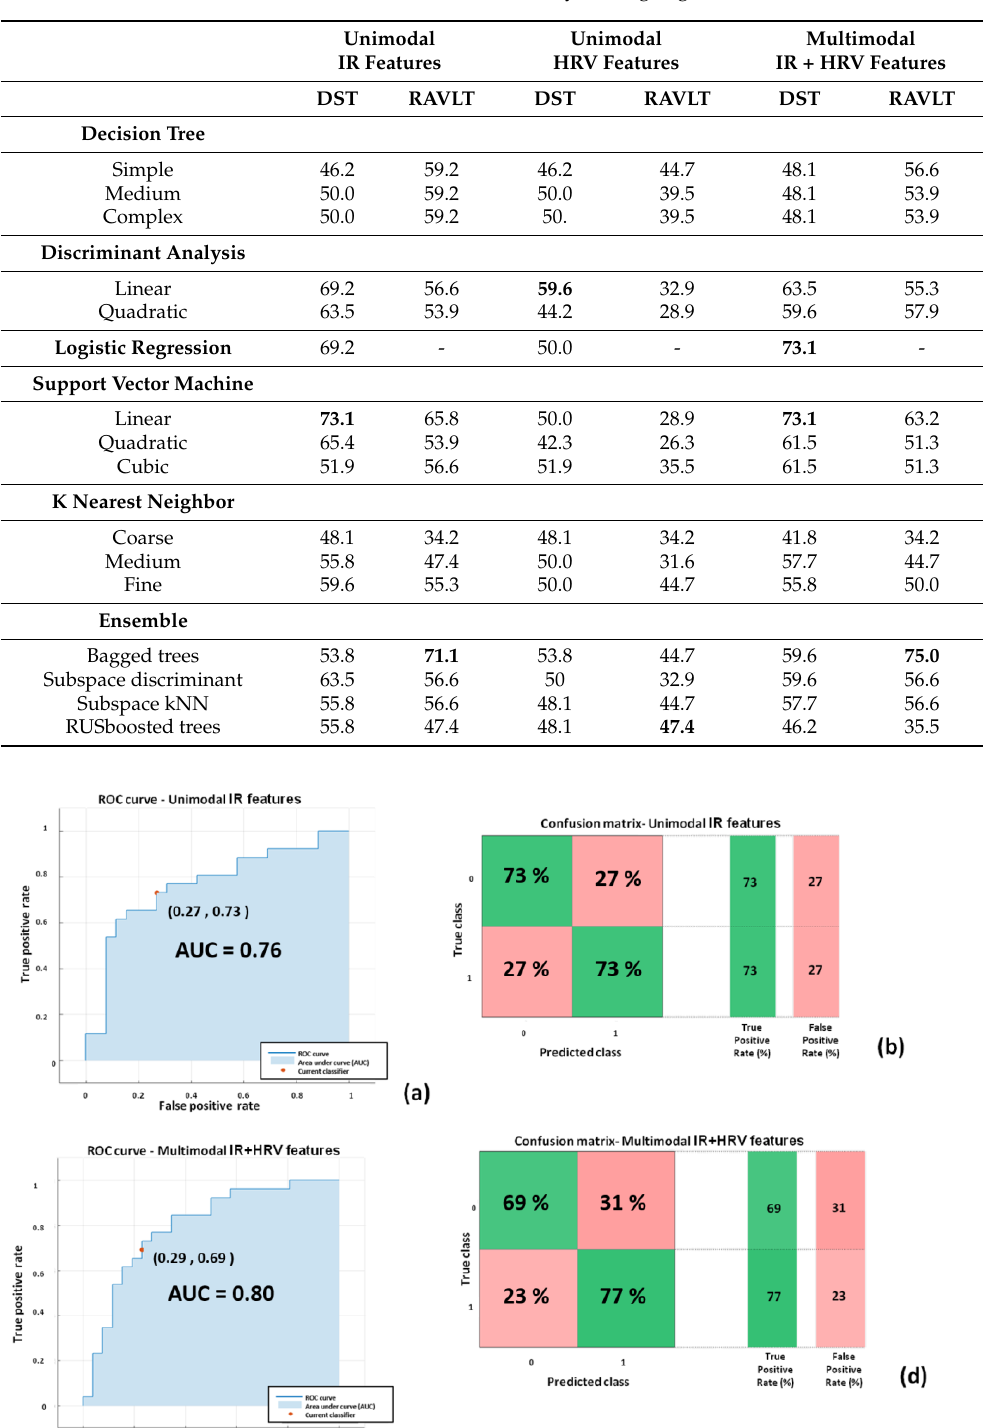
Table 4. Accuracy of the ML classifier for unimodal IR, unimodal HRV and multimodal IR + HRV features-based models. The models with the best accuracy are highlighted in bold.